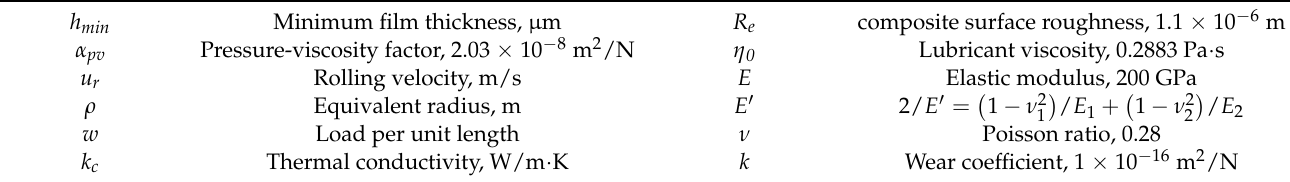
Table 1. Values of the variables for calculating film thickness ratio.